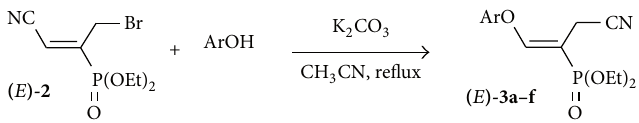
Scheme 2: Basic O -vinylation of phenols with allyl bromide 2 .